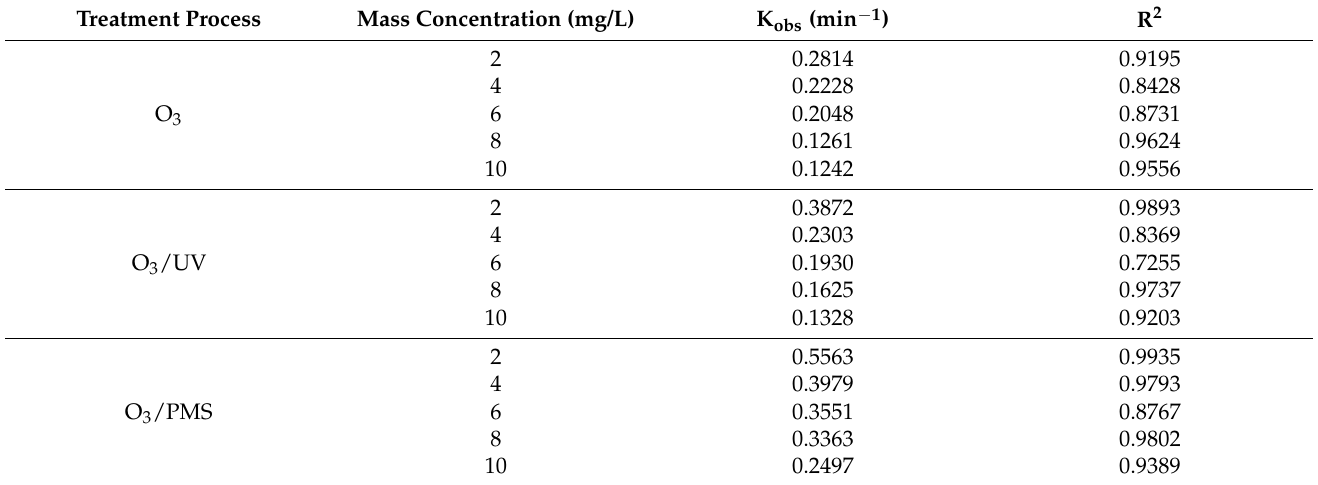
Table 3. Pseudo-first-order rate constants of O 3 , O 3 /UV, and O 3 /PMS under different initial mass concentrations of SDZ (reaction conditions: SDZ = 2, 4, 6, 8, 10 mg/L, O 3 = 3 mg/L, T = 25 ± 0.5 ◦